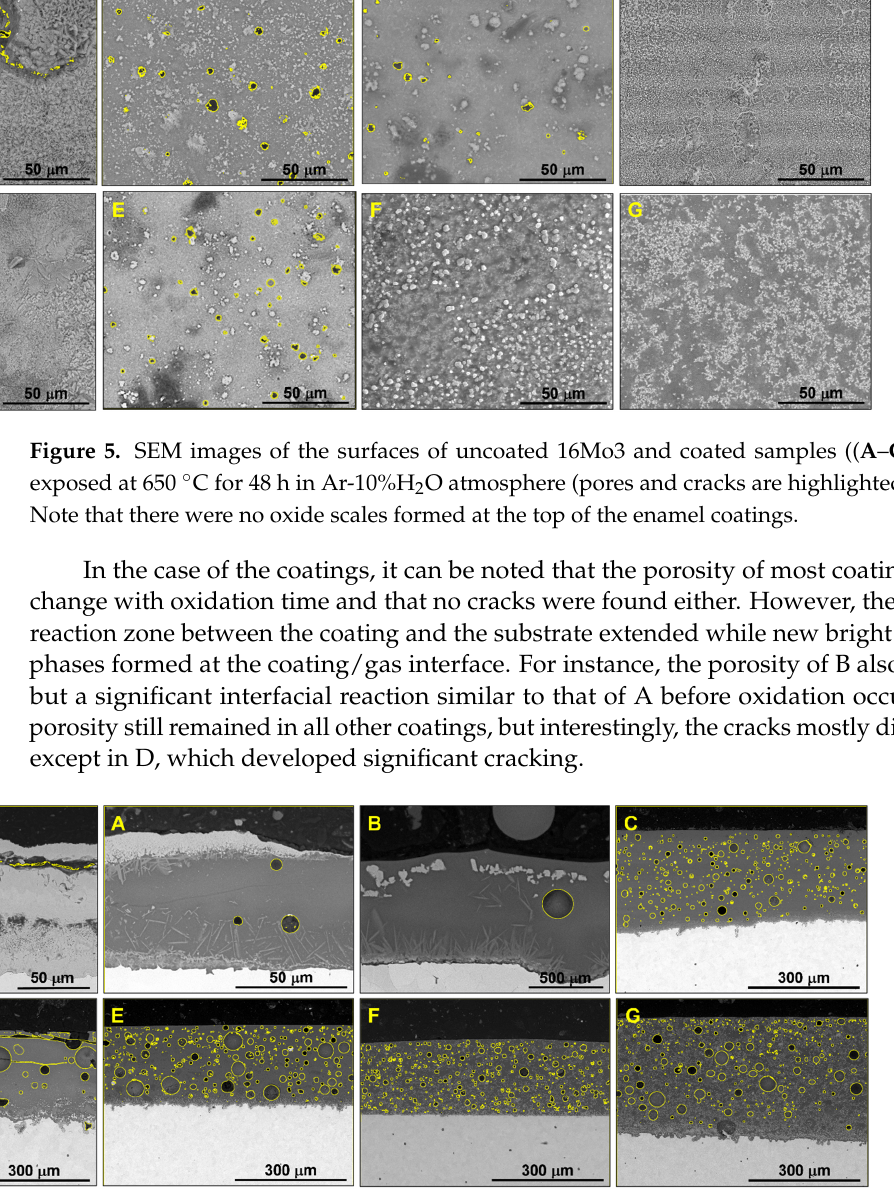
Figure 6. SEM images of cross sections of uncoated 16Mo3 and coated samples ( A – G ) exposed at 650 °C for 48 h in Ar-10%H 2 O atmosphere (pores and cracks are highlighted in yellow).